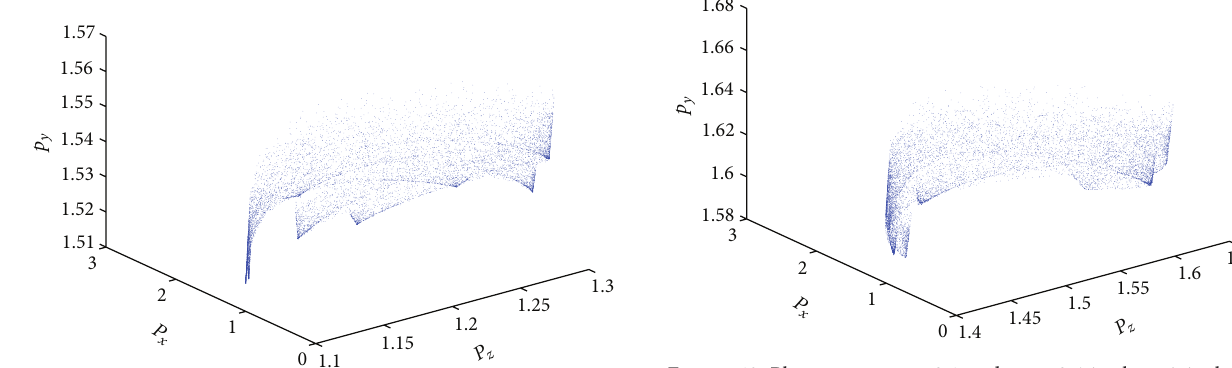
Figure 13: Plots versus 𝑠 2 = 0.1 and 𝑠 3 = 0.4 in the original state